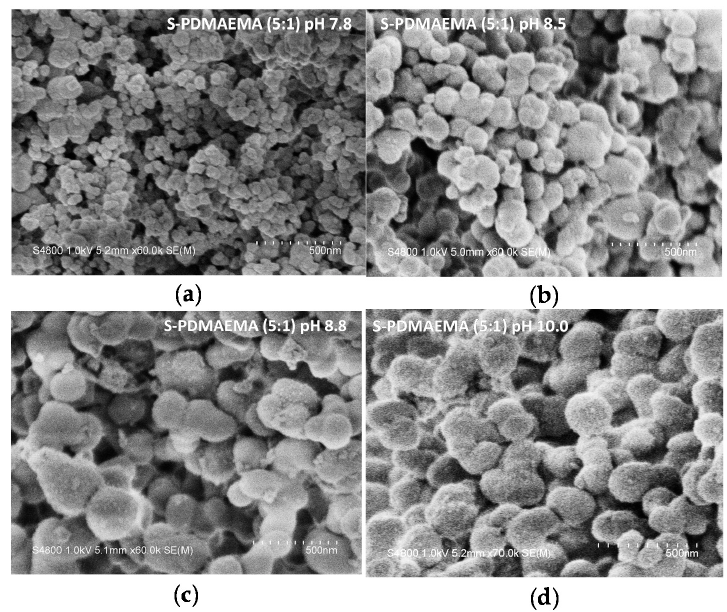
Figure 7. SEM images of S-PDMAEMA 60 precipitates prepared using a 5:1 feed ratio of SS/PDMAEMA